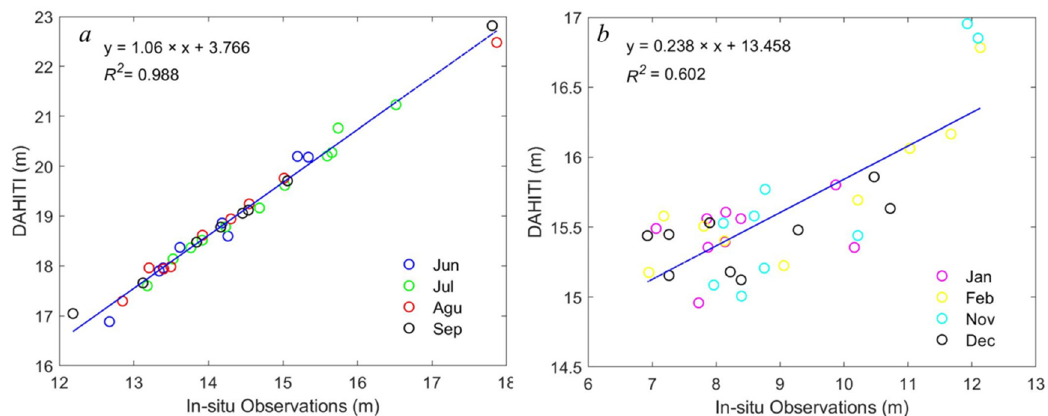
Figure 2. Comparisons of the gauged measurements and DAHITI records in the wet ( a ) and dry ( b ) seasons.